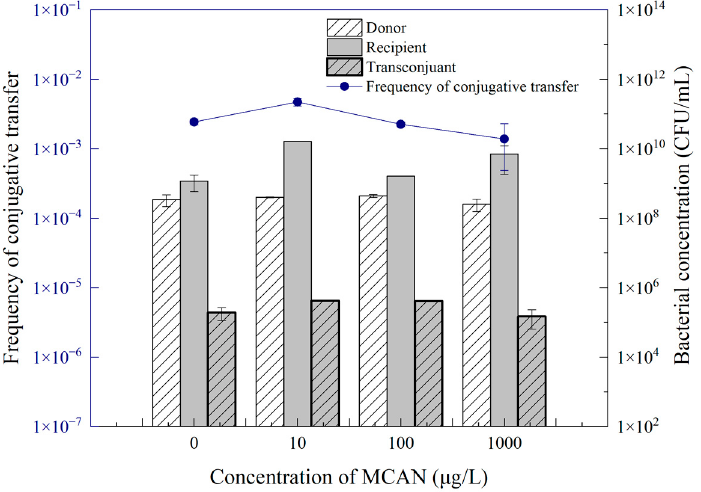
Figure 6. Influence of MCAN on conjugative transfer frequency of ARB ( E. coli HB101). The error lines represent the standard deviation of 3 replicate experiments.